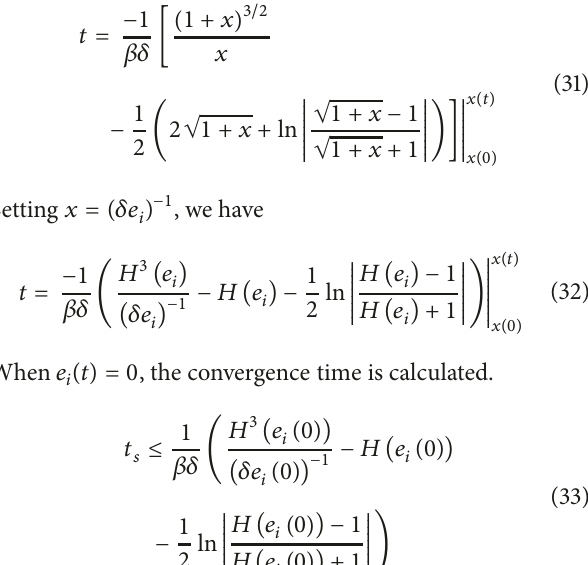
−1 d 𝑡 = √1 + 𝑥(𝛽𝛿𝑥 2 ) d 𝑥 . By means of integral methods,